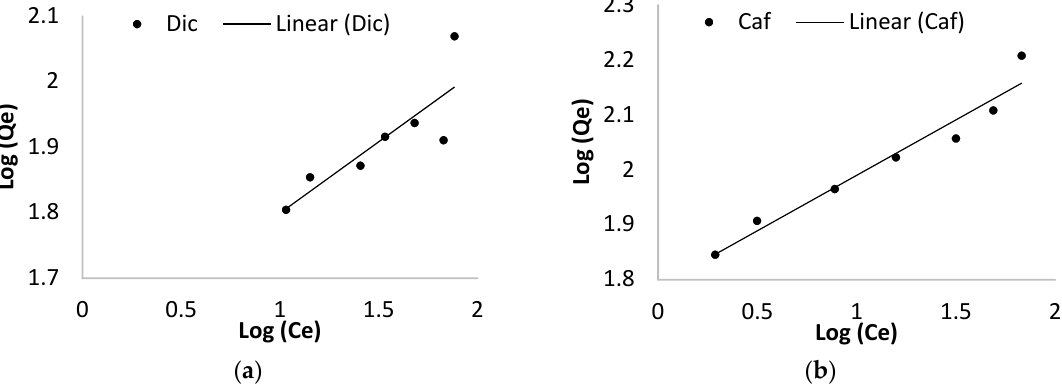
Figure 10. Freundlich isotherm of Dic ( a ) and Caf ( b ) on AC based on argan nutshells. Figure 9 describes the linear equations 1/Qe versus 1/Ce of Dic and Caf on